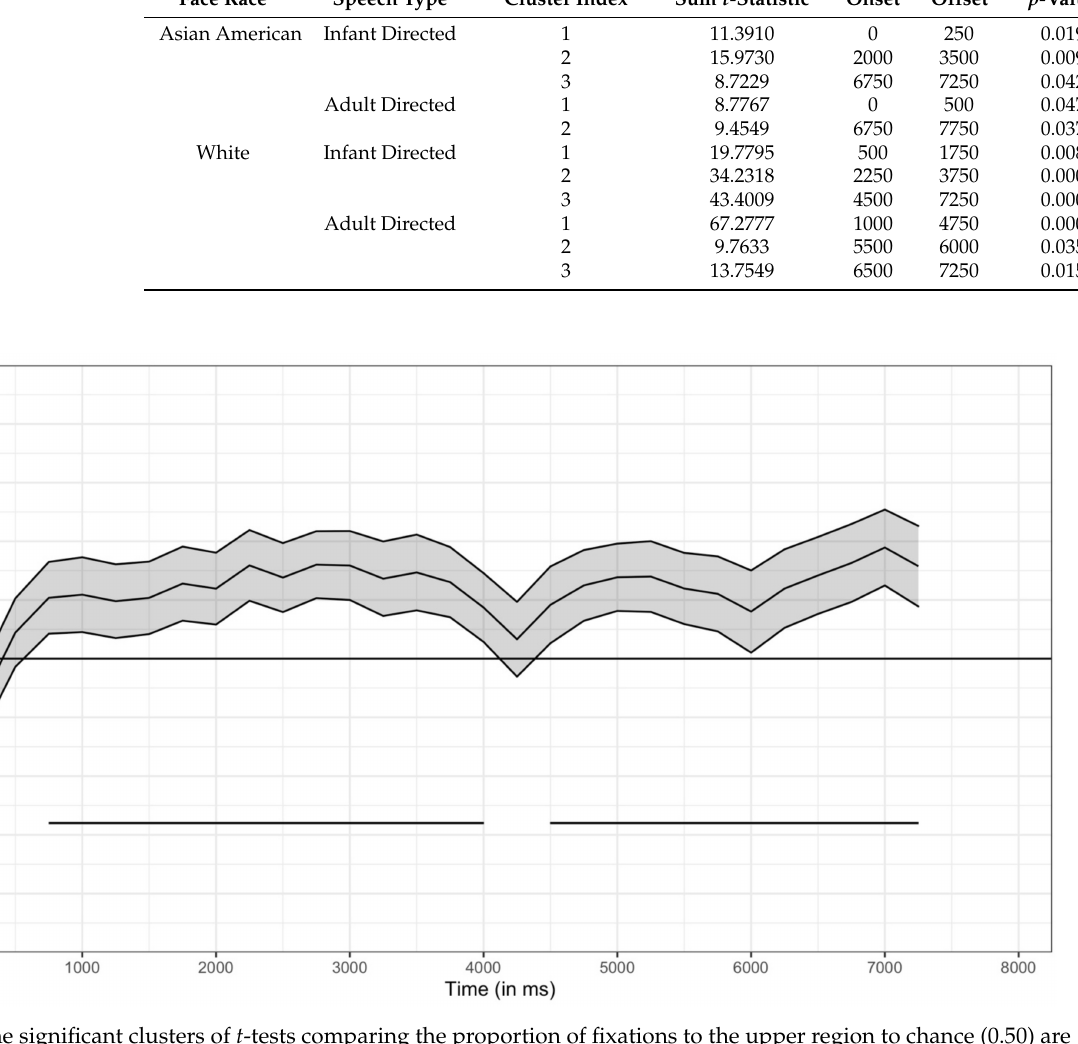
Figure 12. The significant clusters of t -tests comparing the proportion of fixations to the upper region to chance (0.50) are indicated by a line at the bottom of the figure and are listed in Table 5. Recall that the significance of these clusters was established using a permutation analysis which therefore helps to control for multiple comparisons. It can be seen that overall infants fixated on the lower region more than chance between 750 and 4000 ms and between 4500 and 7250 ms, so for nearly the entire